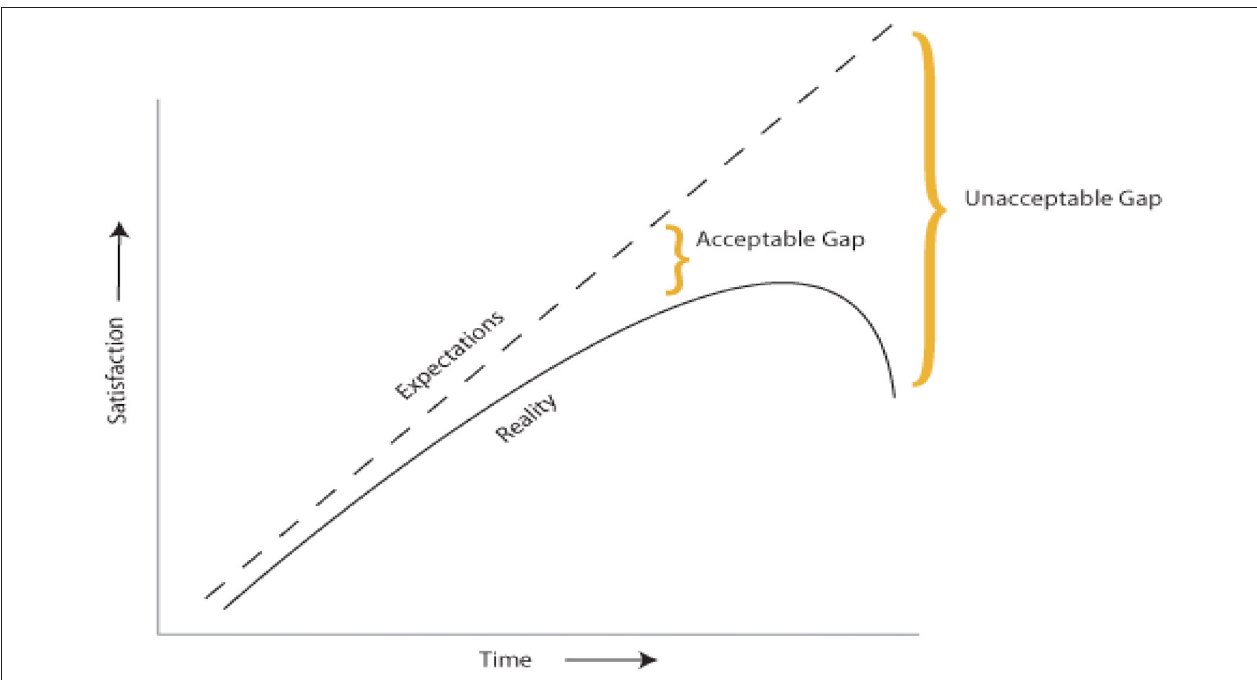
FIGURE 1 | Davies’ J-curve. Source: Davies (1962, p.